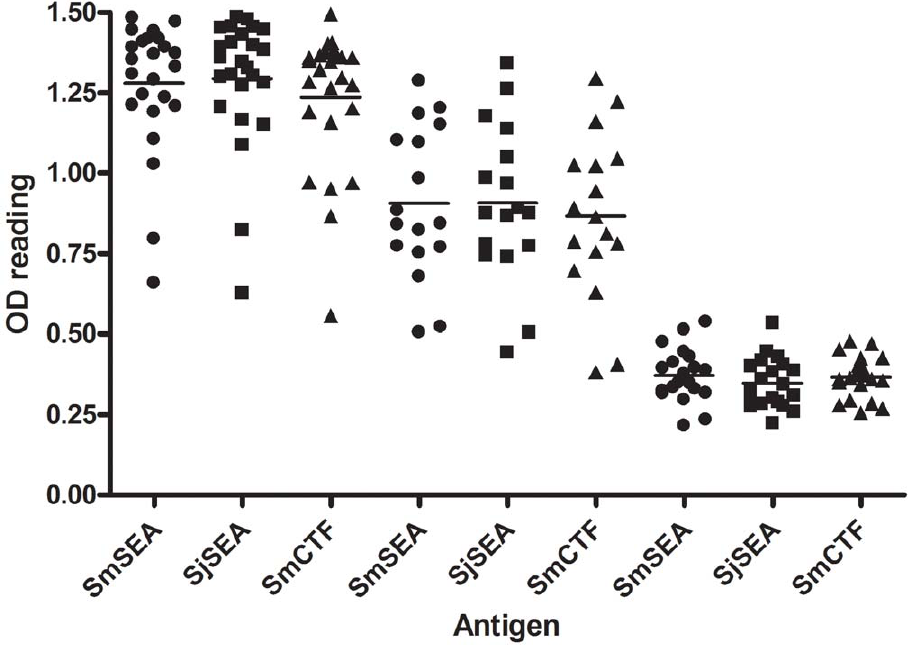
Figure 10. NMU: reactivity of sera from the Peoples Republic of China against S.mansoni SEA (SmSEA), S.japonicum SEA (SjSEA) and S.mansoni CTF (SmCTF) in ELISA. Twenty five sera were from S. japonicum egg-positive subjects and 17 from egg-negative subjects, both groups N living in an area endemic for schistosomiasis japonicum, and 20 sera from negative controls living outwith an endemic area. Horizontal lines indicate SmSEA & SjSEA m the mean OD450 values for each antigen in each of the subject groups.